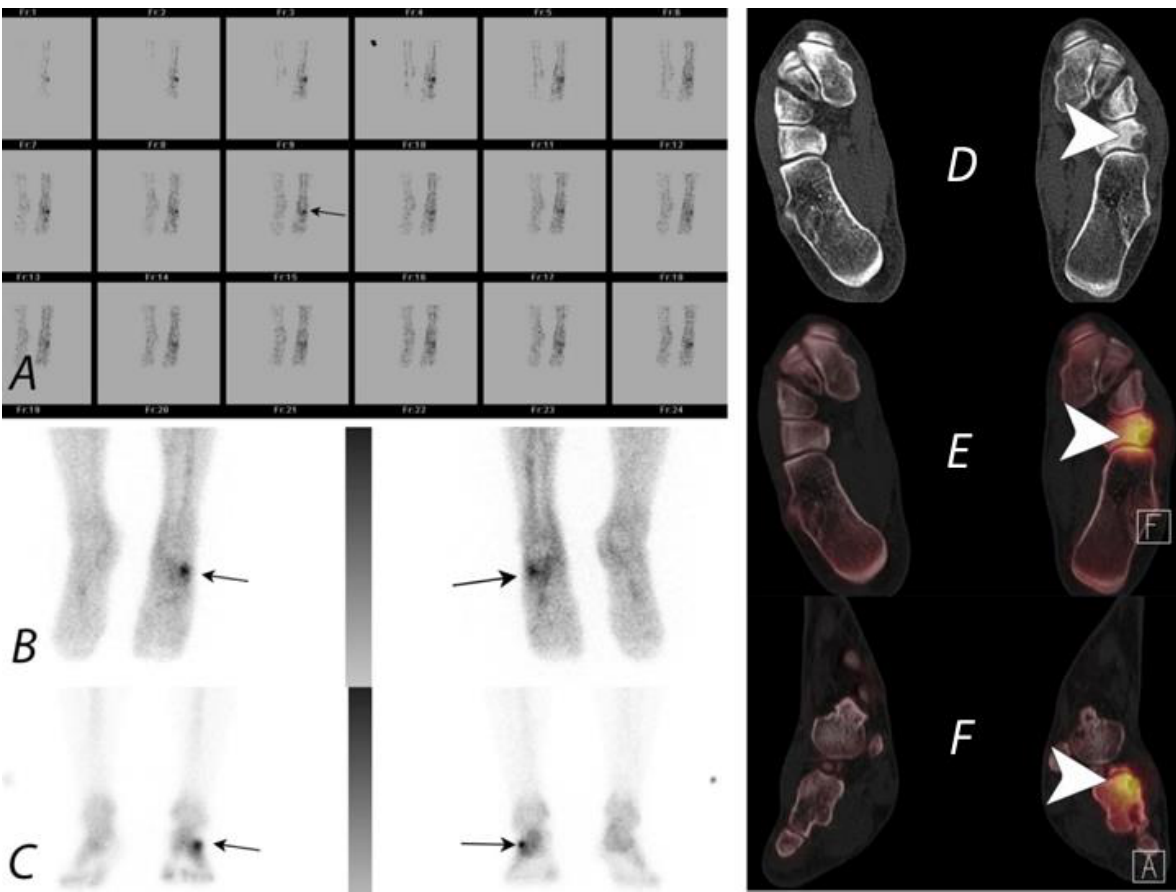
Figure 11. A young patient presenting with chronic left foot pain underwent three phase bone scan with SPECT/CT. Radiographs were interpreted as normal (not shown). Blood flow and pool images ( A , B ) demonstrate increased blood flow and pool activity with focal accumulation of activity on the delayed images ( C ) along the lateral aspect of the mid foot (black arrows). Axial CT image ( D ) and fused axial ( E ) and fused coronal ( F ) SPECT/CT images localize the activity to a well-defined lytic lesion with (white arrowheads) well defined sclerotic rim and a nidus involving the cuboid bone and was interpreted as a possible osteoid osteoma. Patient underwent biopsy, which revealed the lesion to be a benign cartilaginous neoplasm.